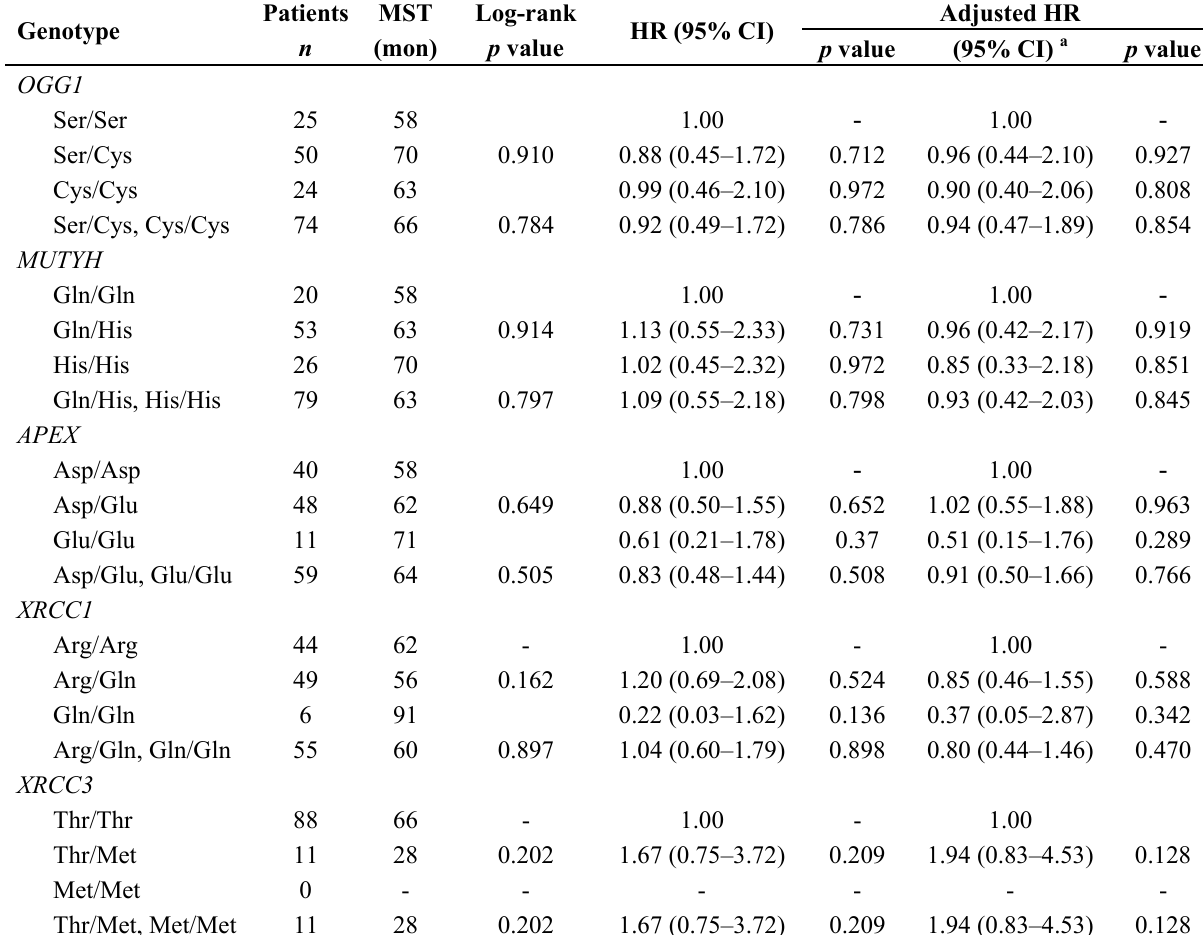
Table 2. DNA Repair Gene Polymorphisms and Patient